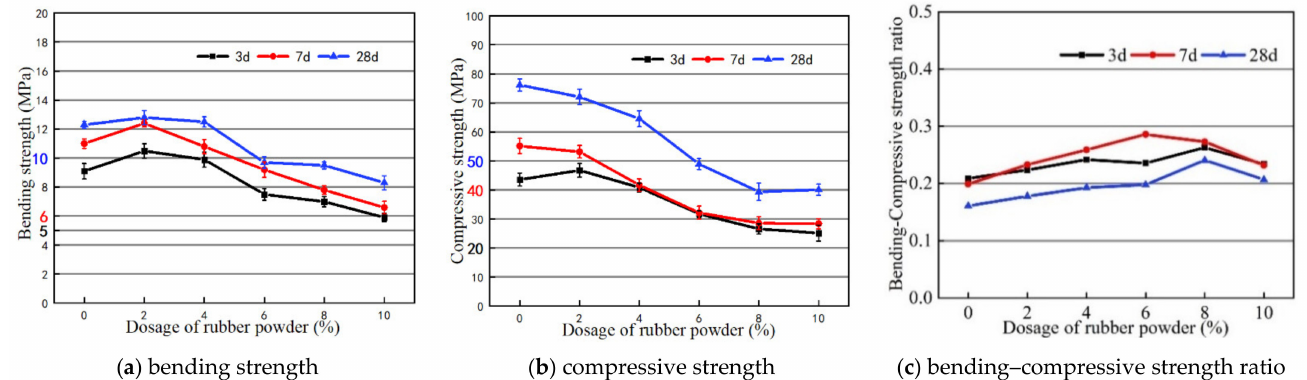
Figure 3. Mechanical strength of PPG with untreated 20 mesh of crumb rubber at different dosages.